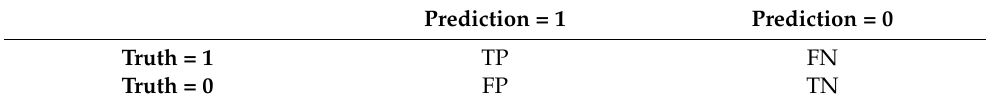
Table 8. Confusion matrix used in calculating CSI, HSS, and